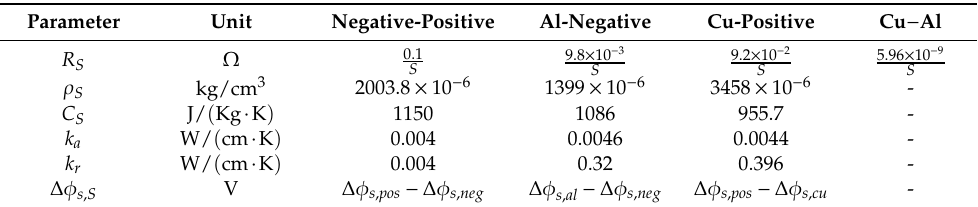
Table 4. Parameters of di ff erent internal short circuit (ISC)